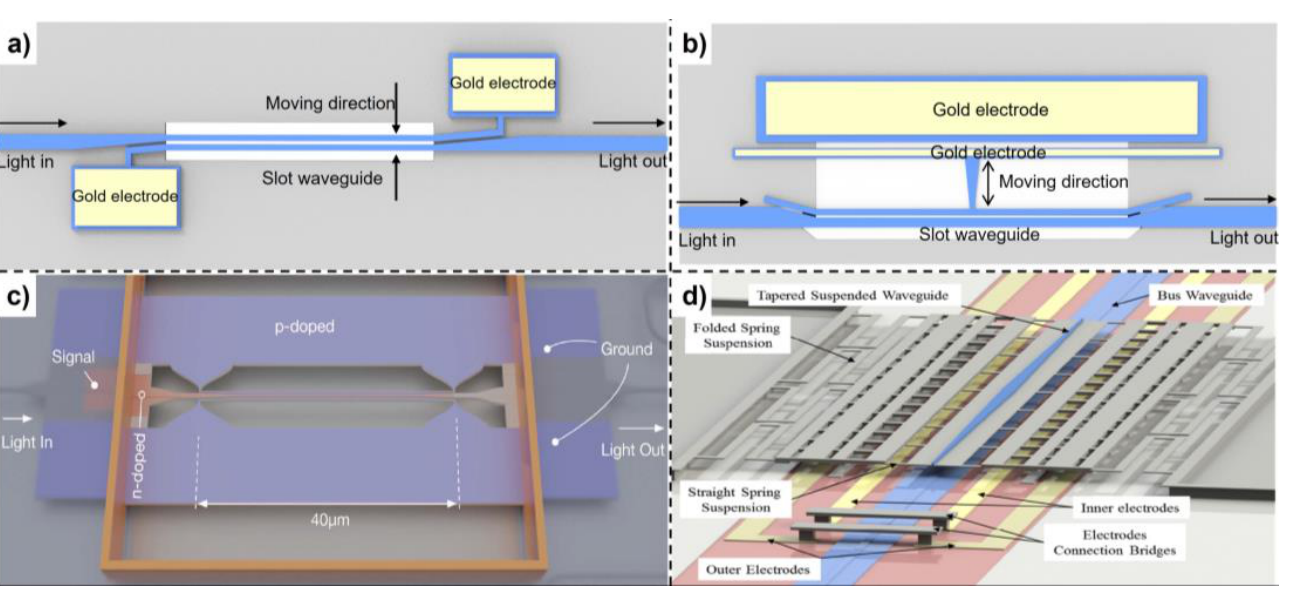
Figure 4. MEMS phase shifter through confined optical mode modulation utilizing ( a ) symmetric slot waveguide, ( b ) asymmetric slot waveguide, ( c ) dual slot waveguide (reprinted with permission from [59] © The Optical Society), ( d ) vertical directional coupler (reprinted with permission from [60] © The Optical Society).